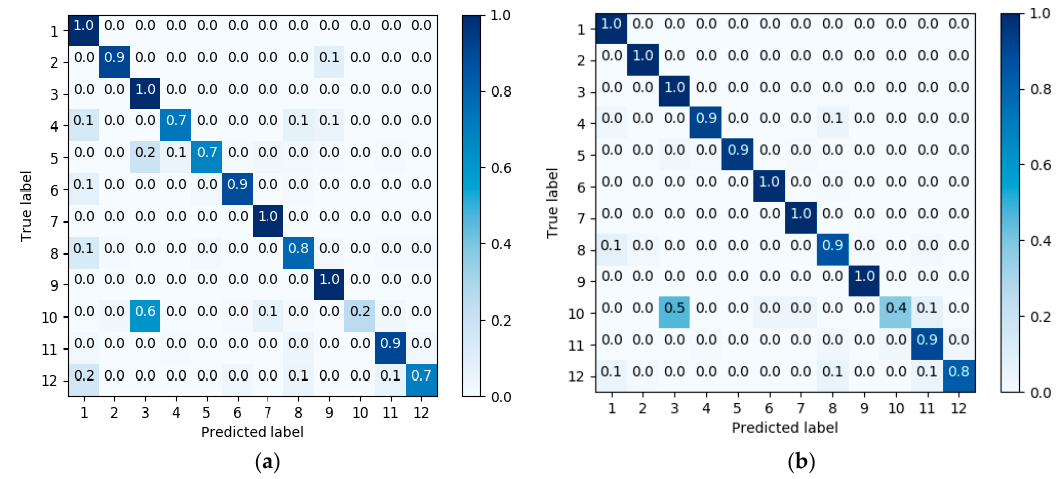
Figure 9. Confusion matrices for AID using: ( a ) 𝐿 (cid:3030)(cid:3032) loss, and ( b ) the total loss 𝐿 = 𝐿 (cid:3030)(cid:3032) + 𝐿 (cid:3035) + 𝐿 (cid:3042) .